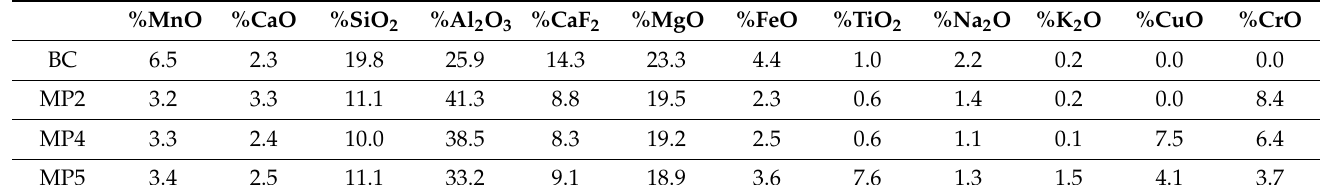
Table 3. Bulk chemical compositions of post-weld slags (mass%).